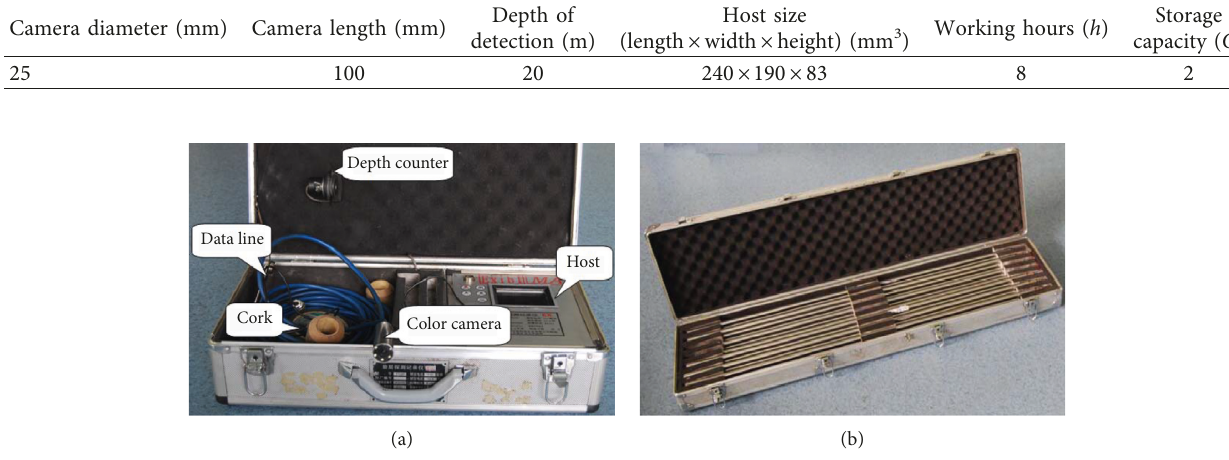
Table 3: Main parameters of the YTJ20 borehole detection recorder.